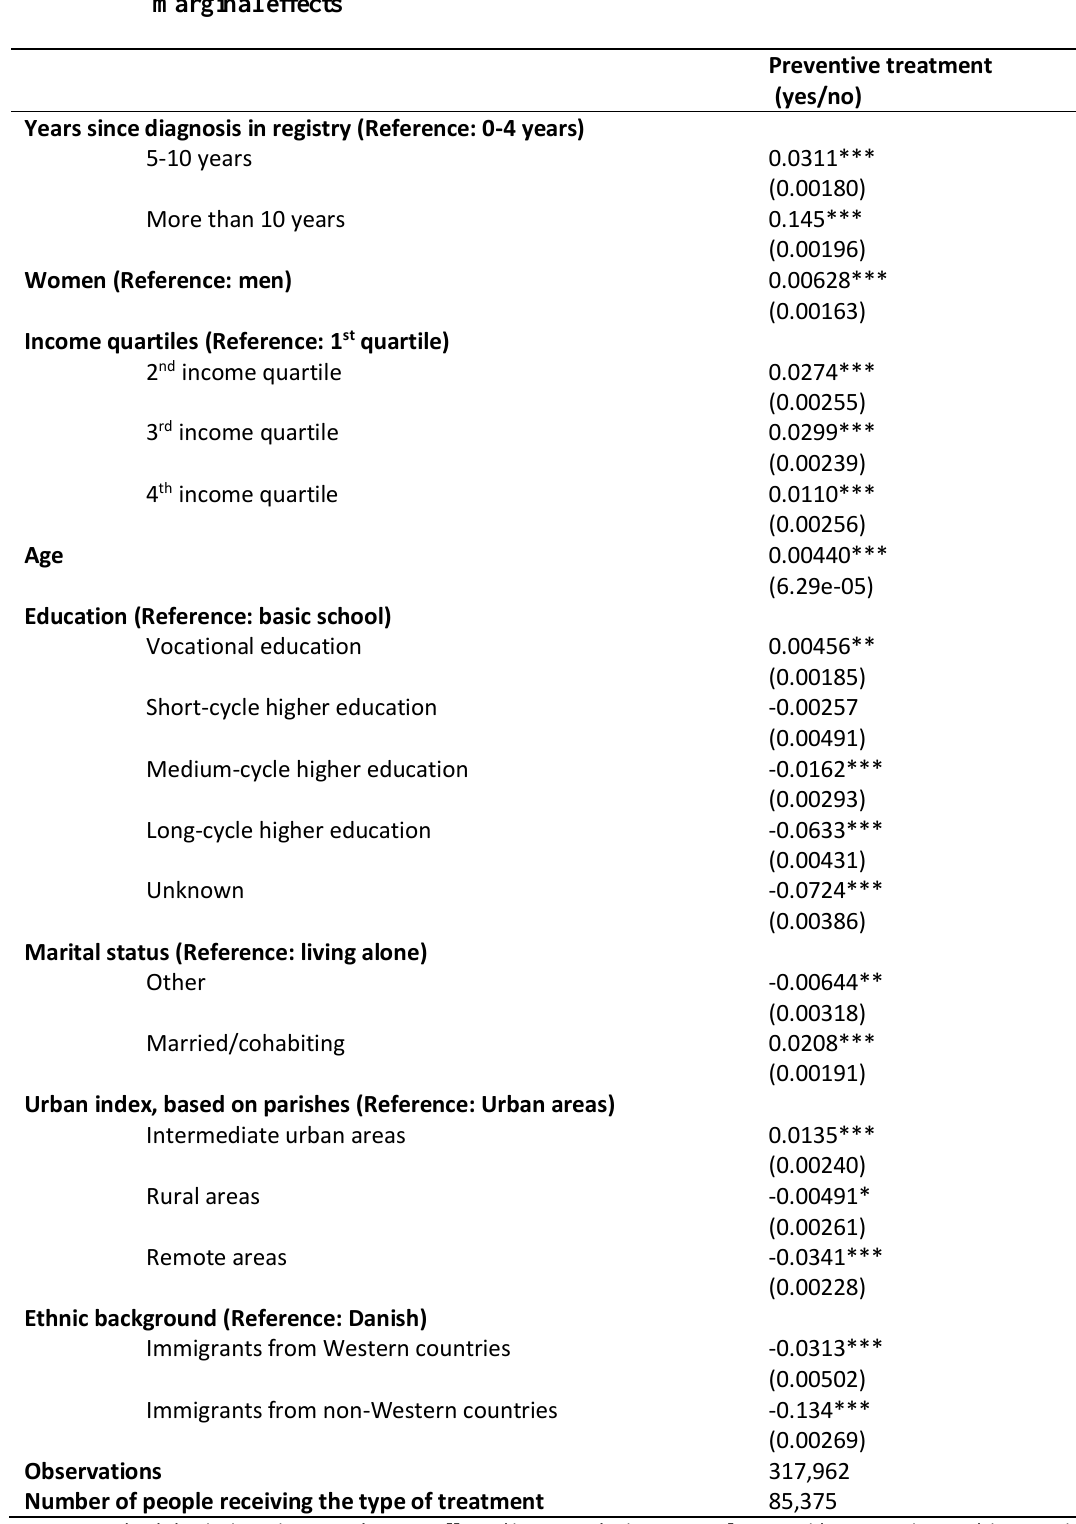
Logistic regression on the use of publicly supported foot therapy 2012, marginal